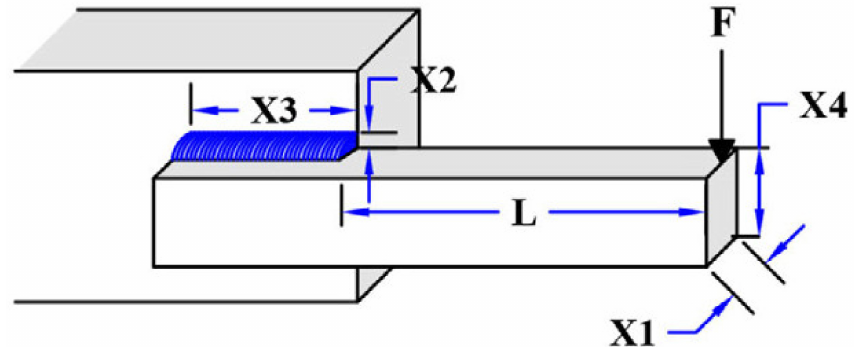
Figure 12. Welded beam